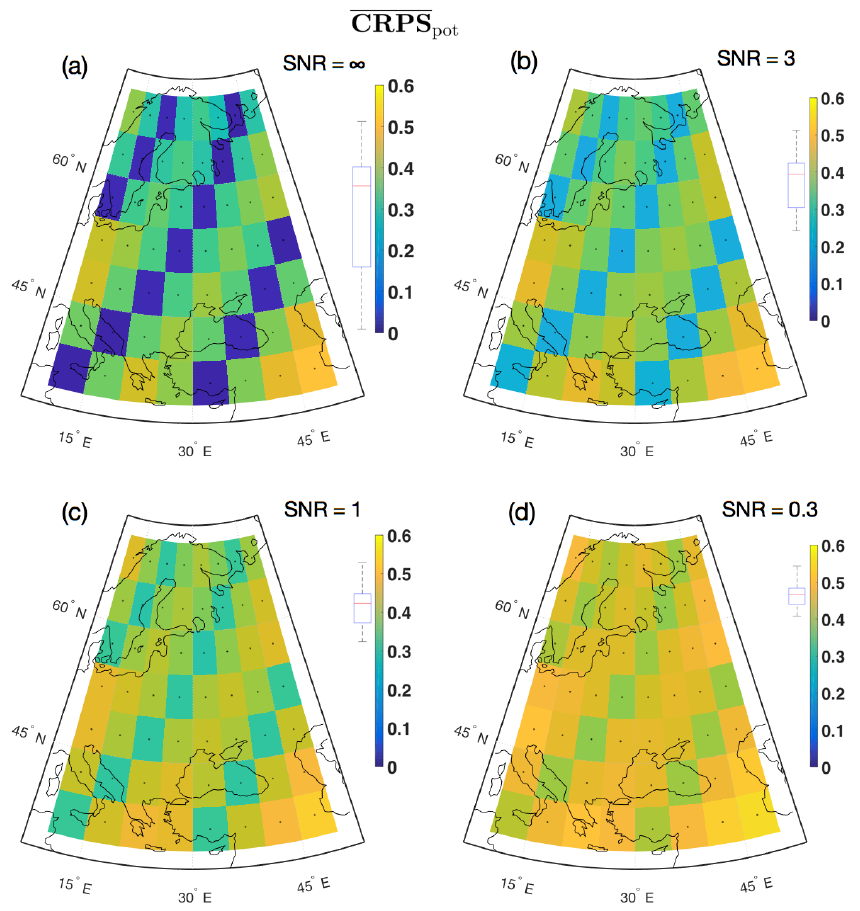
Figure 9. Local CRPS pot between reconstructed temperature field and target field for the verification period. The box plots left of the color bars indicate the distribution of grid point correlation coefficients. β =